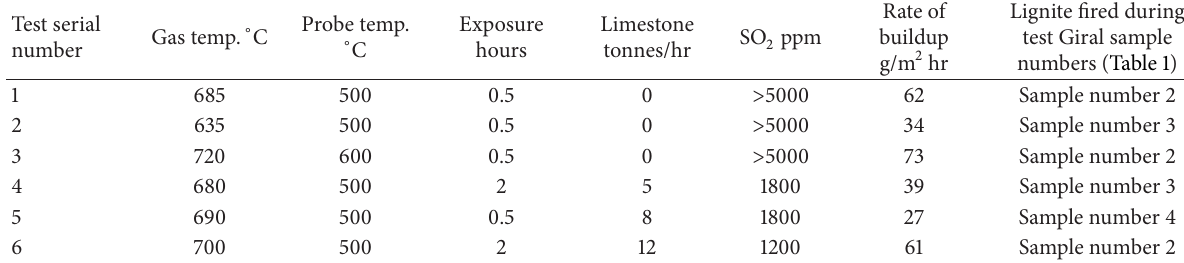
Table 4: Deposit sampling using probes.